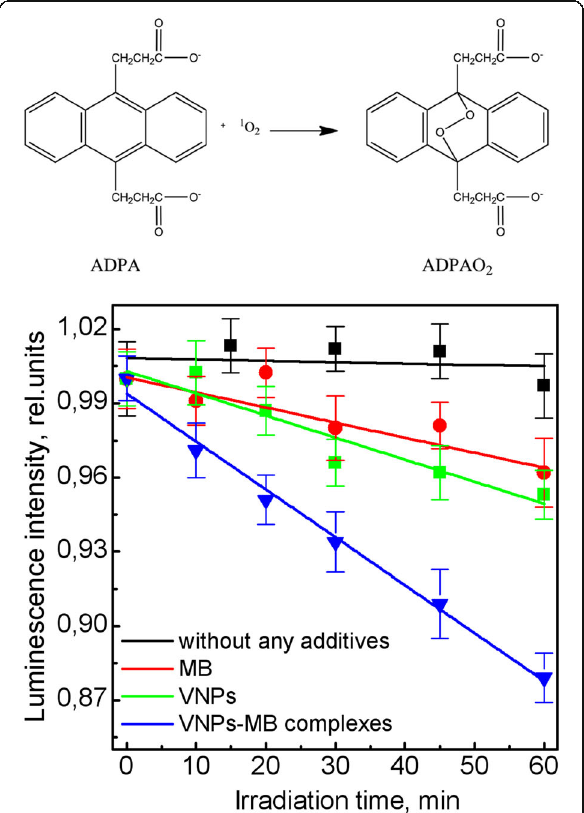
Fig. 5 Reaction of ADPA with singlet oxygen to form endoperoxide ADPAO 2 . ADPA photobleaching after irradiation with λ = 457 nm in water